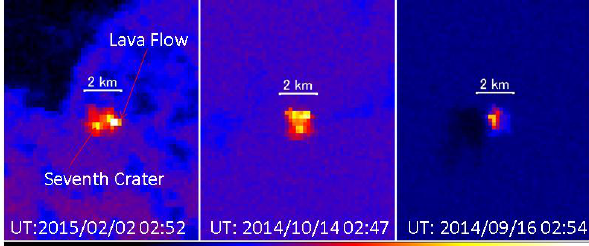
Figure 15. Nishi-no-shima in Japan.